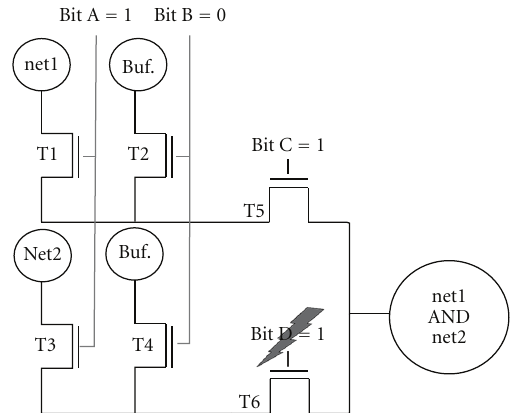
Figure 6: Example of a row bridging short. Bit D was a ff ected by an SEU.